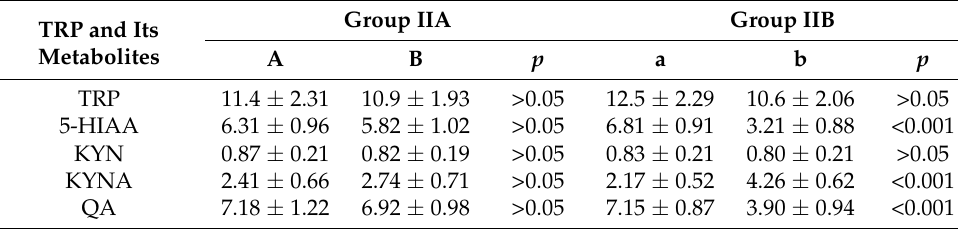
Table 5. Urinary excretion of tryptophan (TRP) and its metabolites: 5-hydroxyindoleacetic acid (5-HIAA), kynurenine (KYN), kynurenic acid (KYNA), and quinolinic acid (QA) in patients with diarrhea-predominant irritable bowel syndrome without (IIA) and with (IIB) reduction of TRP intake; before (a) and after (b) nutritional intervention; all results expressed in units—mg/gCr; average ± SD.